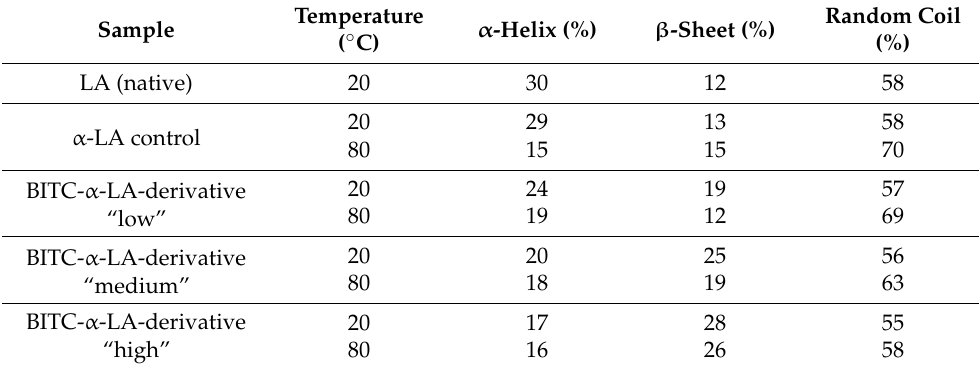
Table 2. Quantification of the secondary structural composition of the proteins at 20 ◦ C and 80 ◦ C.